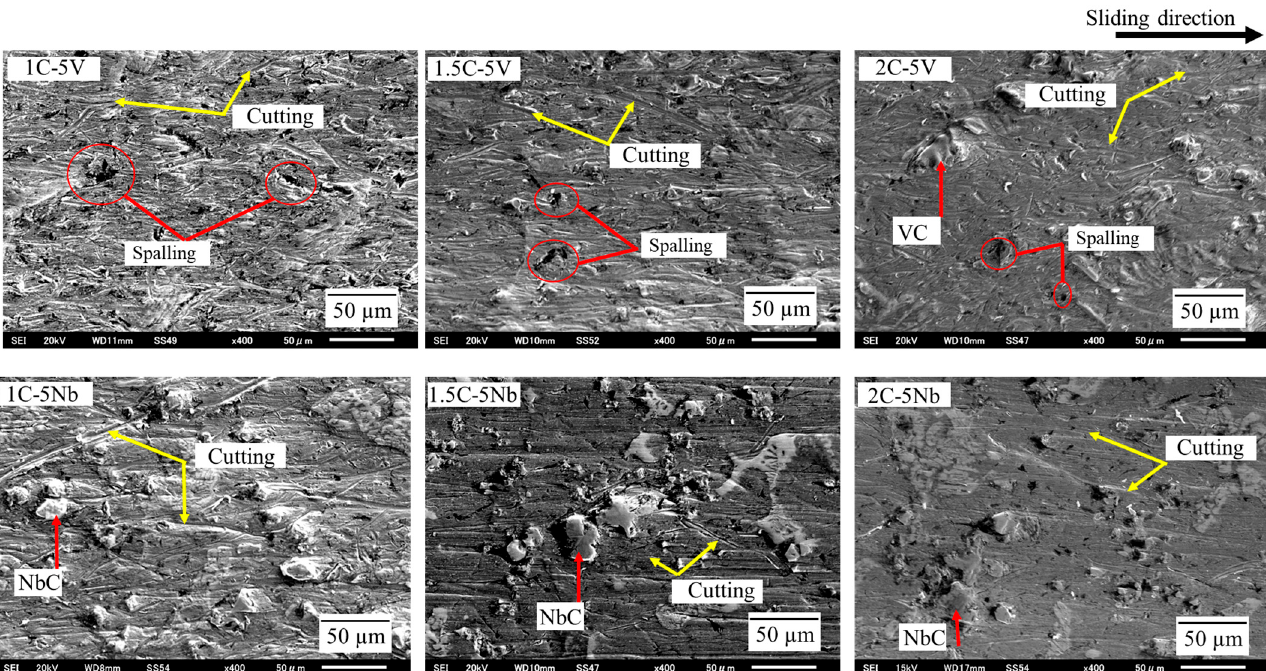
Figure 11. Investigation of abrasive wear mechanisms through worn surfaces using SEM.